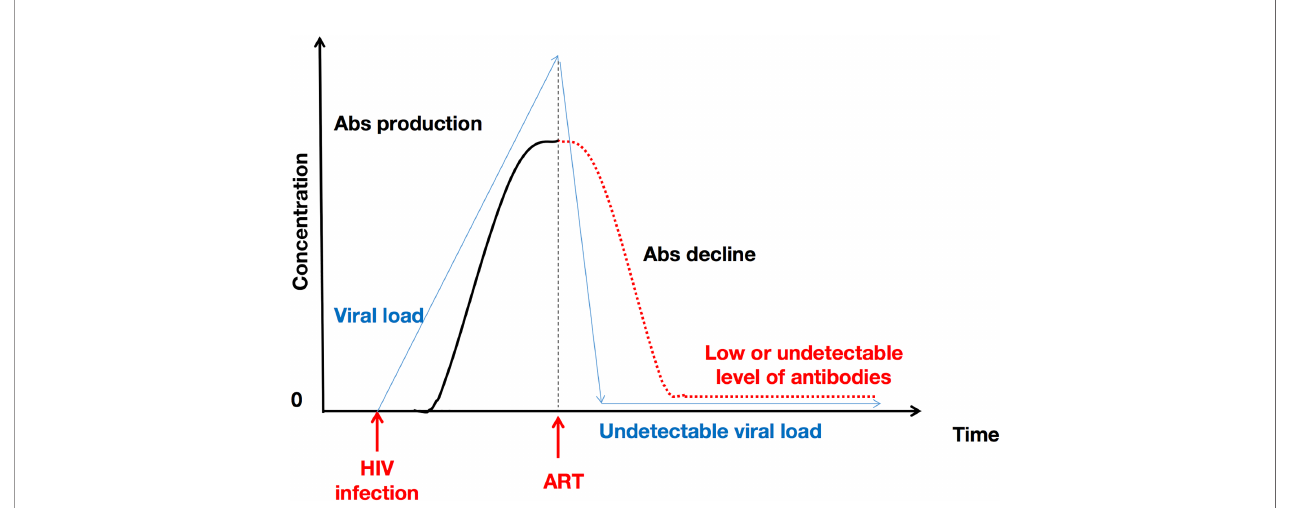
FIGURE 2 | ART initiation and uninterrupted administration over time induces a decline in HIV antibody concentration. This represents the particular case of adults. ART provokes a decrease in viral RNA copies, which in turn explains the subsequent decrease in HIV-1-speci fi c antibody levels. Abs,